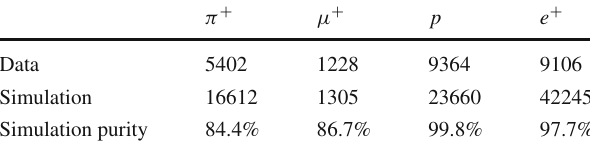
Table 2 Numbers of events after the beam quality and number of hits selection criteria shown for experimental data and simulation